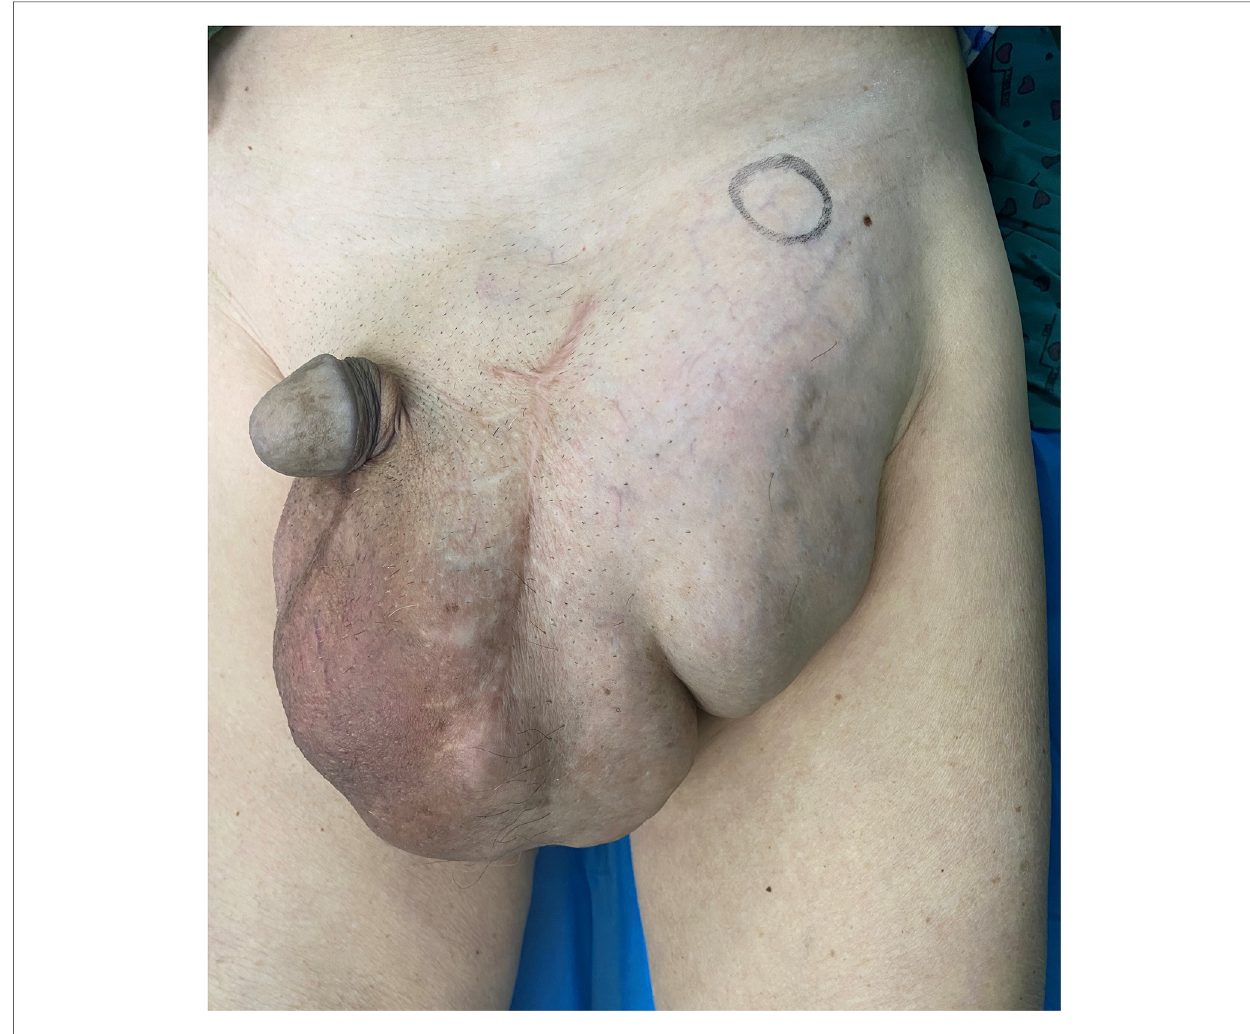
FIGURE 1 On physical examination, a lump of about 25 cm×20 cm in size could be felt in the left scrotum and groin area, with tough texture and clear